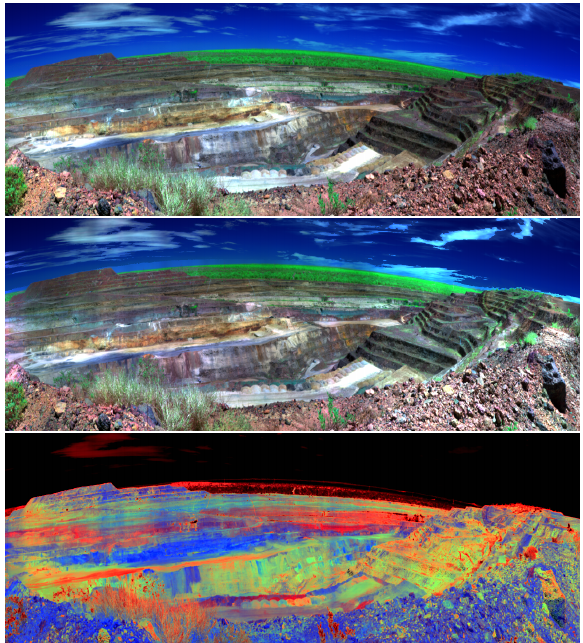
Figure 8. Open pit mine example 2, top: false color radiance ((R:2200nm, G: 1050nm, B:610nm); middle: DROACOR-H reflectance output, same spectral bands; bottom: inverse SAM quantification with: R: Kaolinite, G: Hematite, B: Goethite.